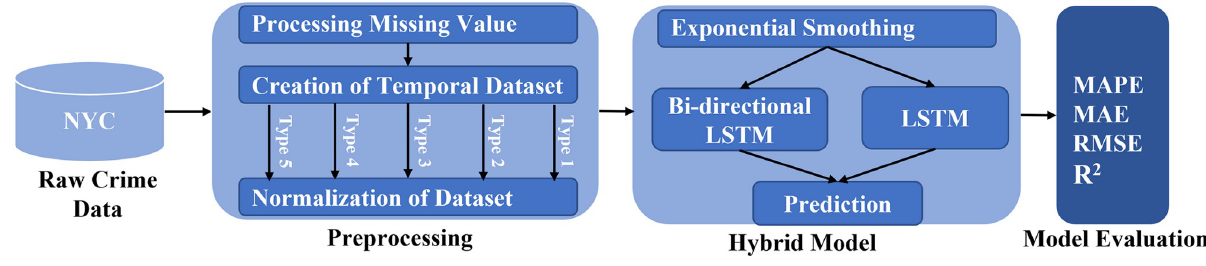
Fig 1. Methodology for crime